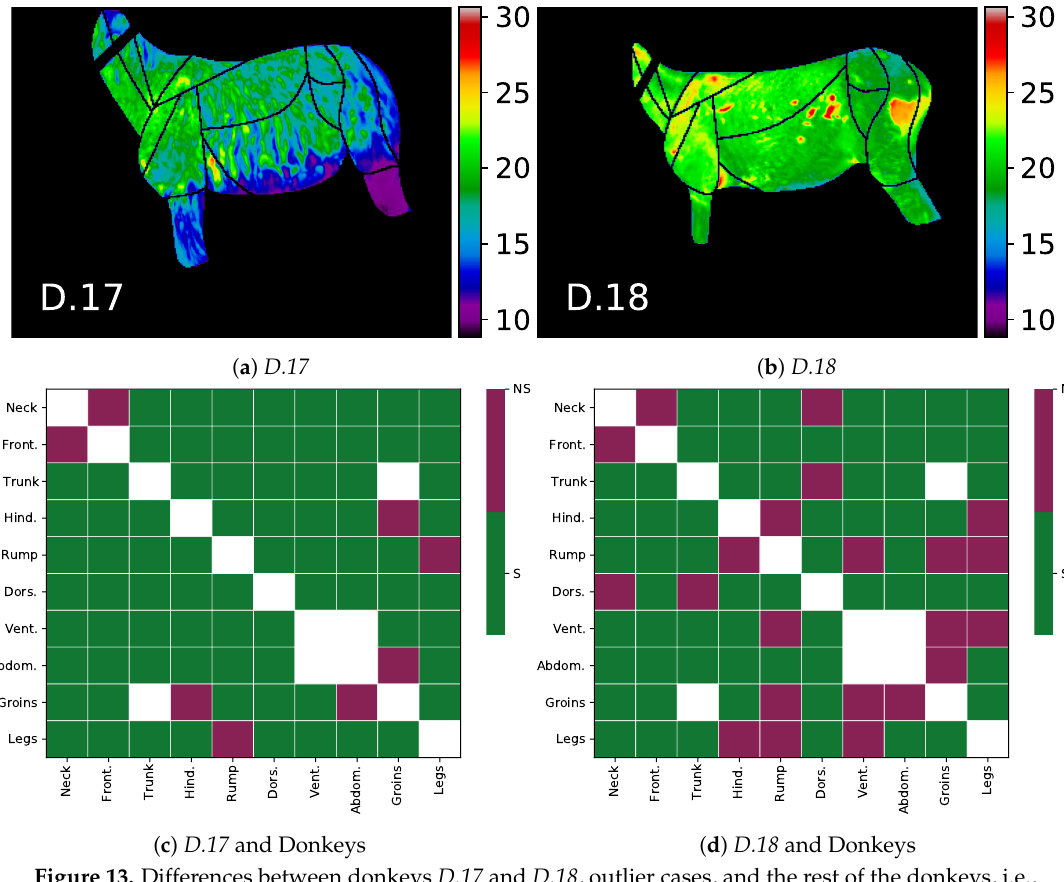
Figure 13. Differences between donkeys D.17 and D.18 , outlier cases, and the rest of the donkeys, i.e., animals D.1-16 . The upper panels present thermal maps of the two cases: ( a ) donkey D.17 ; ( b ) donkey D.18 . Donkey D.17 was colder than other animals due to its long hair length. Donkey D.18 had an unusual pattern of warm areas resulting from patchy hair loss. Bottom plots show differences in the thermal patterns of these donkeys compared to the global pattern of other donkeys: ( c ) donkey D.17 compared to other donkeys; ( d ) donkey D.18 compared to other donkeys. The S class (green) indicates that the individual animal pattern was in line with the global trend, and class NS (red) indicates the